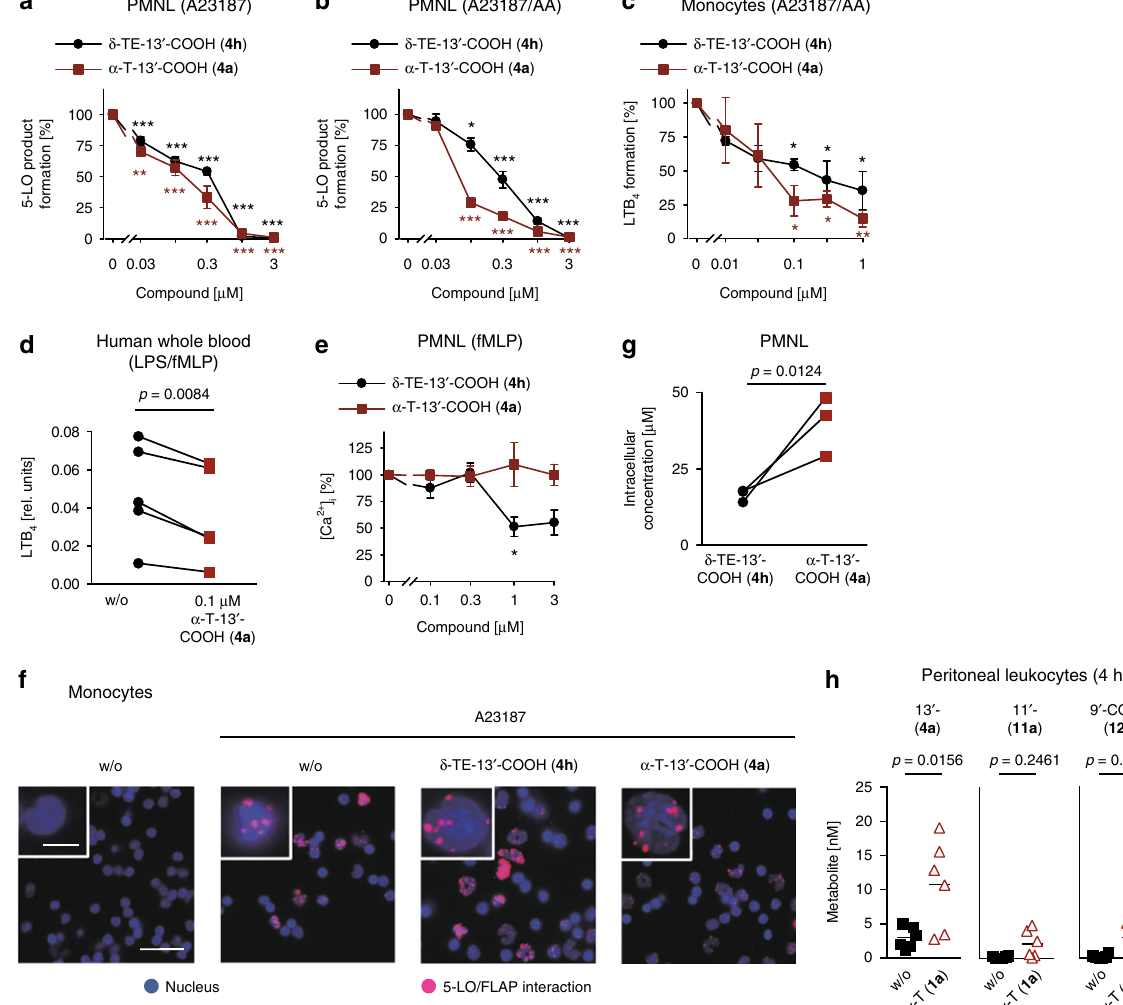
Fig. 3 Accumulation of α -T-13 ′ -COOH ( 4a ) in immune cells favors inhibition of 5-LO. a – c Effects of α -T-13 ′ -COOH ( 4a ) and δ -TE-13 ′ -COOH ( 4h ) on the formation of 5-LO products (LTB 4 , its isomers and 5-H(P)ETE analyzed by RP-HPLC) in PMNL treated with Ca 2 + -ionophore A23187 ( a ) plus AA ( b ) and on LTB 4 formation (analyzed by UPLC-MS/MS) in A23187/AA-activated monocytes ( c ) and LPS/fMLP-stimulated human blood ( d ). e Intracellular Ca 2 + concentration ([Ca 2 + ] i ) in fMLP-stimulated PMNL treated with α -T-13 ′ -COOH ( 4a ) or δ -TE-13 ′ -COOH ( 4h ). f In fl uence of α -T-13 ′ -COOH ( 4a ) and δ -TE- 13 ′ -COOH ( 4h ; 3 µ M, each) on the formation of the 5-LO/FLAP complex in A23187-activated monocytes as determined by proximity ligation assay; scale bar of the outer box: 25 µ m, scale bar of the insert: 5 µ m. Images are representative of three independent experiments. g Uptake of α -T-13 ′ -COOH ( 4a ) and δ -TE-13 ′ -COOH ( 4h ; 150 nM, each) by PMNL, which were treated with either of the compounds for 20 min. Average intracellular concentrations were calculated for spherical PMNL with a diameter of 13 µ m. Interconnected lines indicate data from the same independent experiment. h Accumulation of α -T-13 ′ -COOH ( 4a ) in leukocytes from peritoneal exudates of mice 4 h post zymosan injection. α -T (50 mg/kg) was administered p.o. 1 h before zymosan. Mean± s.e.m. ( a – c , e ), paired data ( d , g ) or mean with single data ( h ) from n = 3 ( a – c , e , g ) or n = 5 ( d ) independent experiments, n = 6 ( h ) mice. * P < 0.05, ** P < 0.01, *** P < 0.001 vs. vehicle control ( a – e , h ) or δ -TE-13 ′ -COOH ( 4h )-treated cells ( g ); repeated measures one-way ANOVA + Tukey